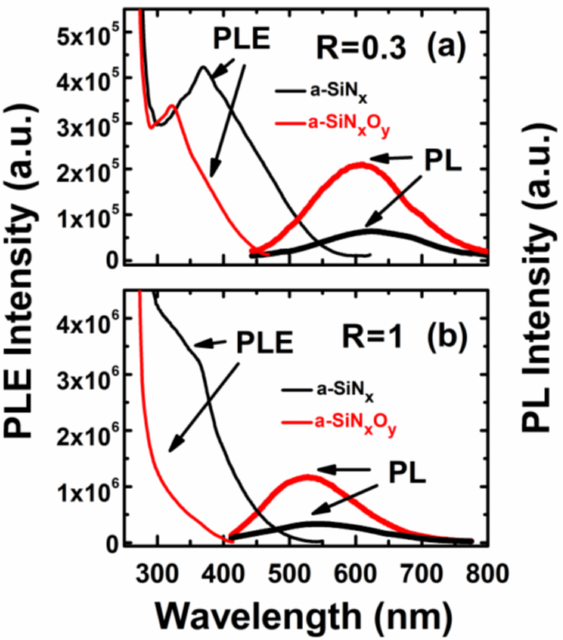
Figure 5. PL and PLE spectra of a-SiN x O y and a-SiN x films with ( a ) R = 0.3 and ( b ) R = 1 at room